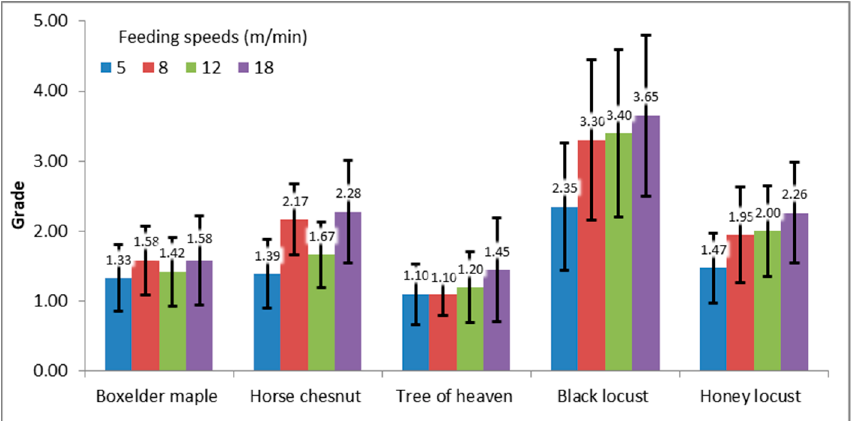
Figure 4. Average surface quality grades and standard deviations for tree species after planing at different feeding speeds.